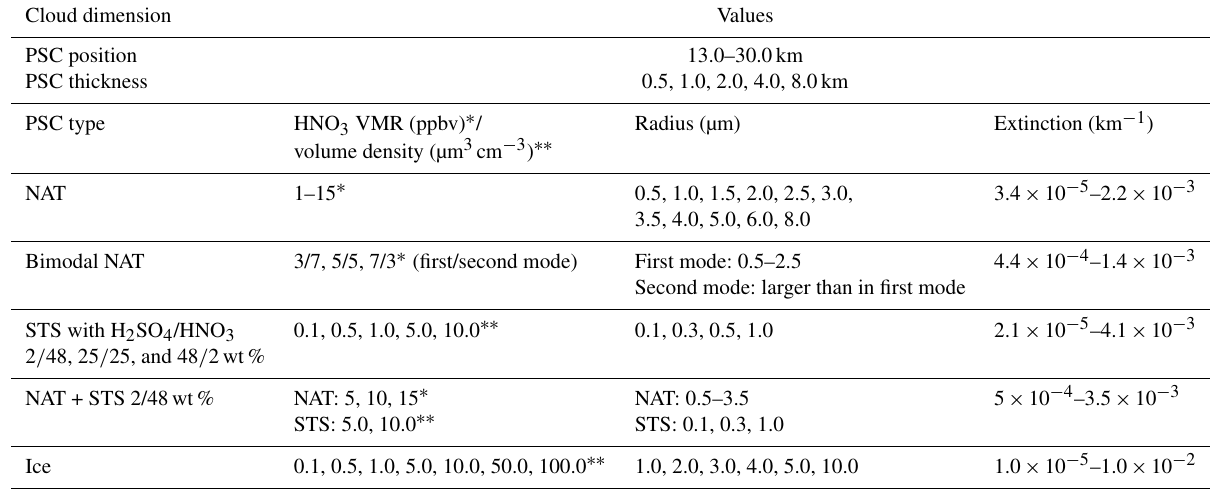
Table 3. Cloud scenario simulation set-up. Please note that “ ∗ ” refers to HNO 3 VMR (ppbv), and “ ∗∗ ” refers to volume density (µm 3 cm − 3 ). Cloud dimension